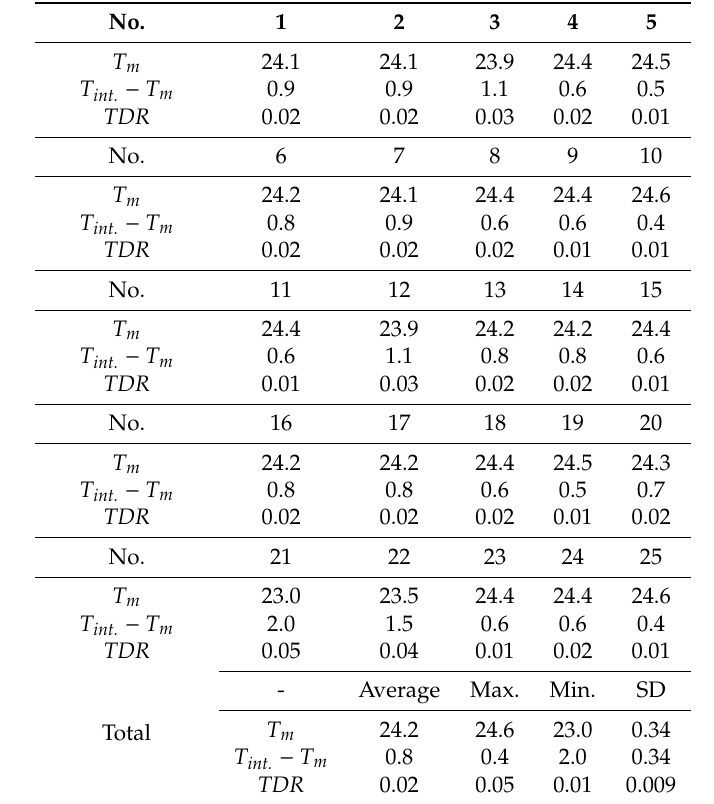
Figure 8. Measurement points for condensation risk. Table 4. Test results of condensation risk (Unit: ◦